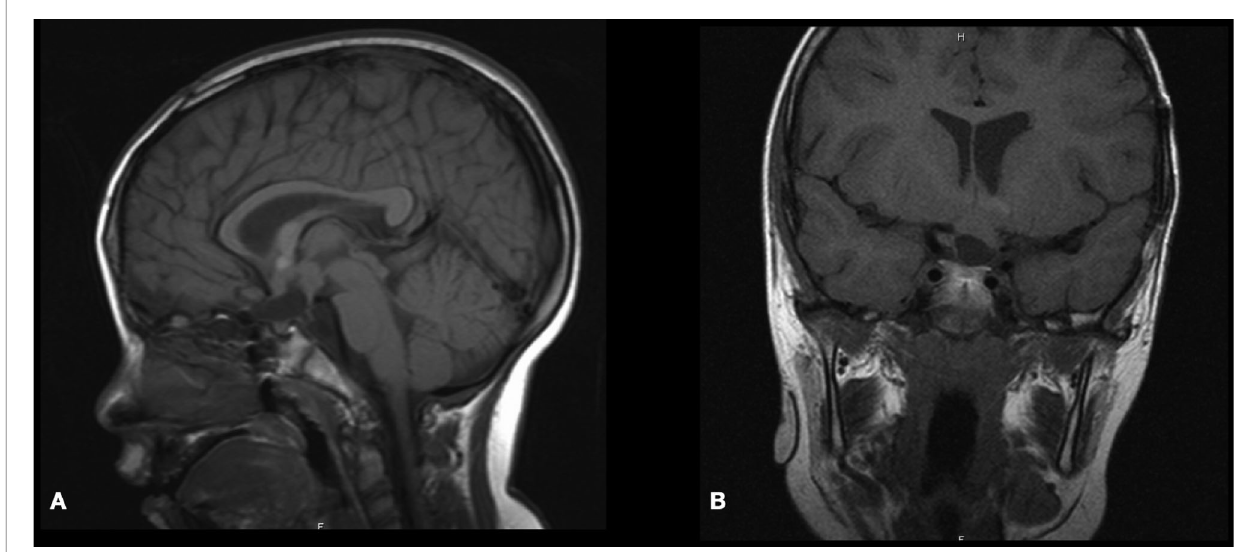
FIGURE 4 | Postoperative sagittal and coronal T1-WI MRI scan demonstrating stable residual tumor at 5-year follow-up.